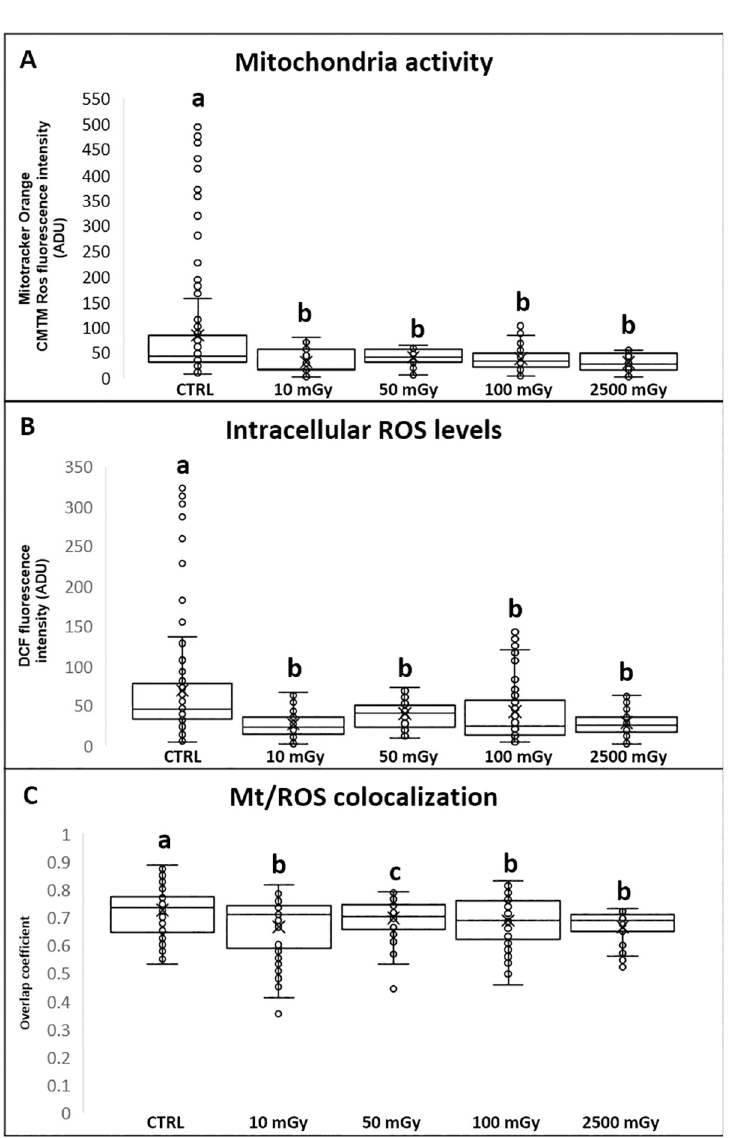
Fig 4. Effects of low-dose X-ray radiations before IVM on blastocyst bioenergetics/oxidative status. Graphs representing mitochondria activity, intracellular ROS levels and mt/ROS colocalization of blastocysts from control oocytes or oocytes exposed to X-ray radiation before IVM and obtained by IVM, IVF and in vitro embryo culture. Mitochondria (mt) activity (panel A) intracellular ROS levels (panel B) and mt/ROS colocalization (panel C) are expressed as in Fig 1. One-way ANOVA followed by Dunnett’s post hoc test: a,b = P < 0.0001, a,c = P <